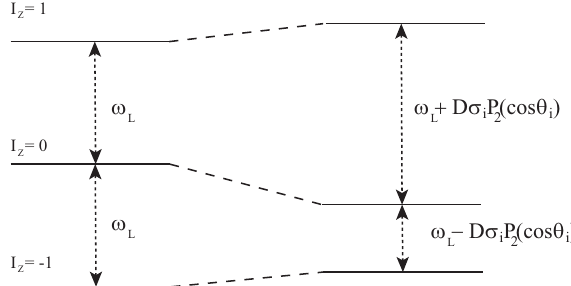
Figure 4. Nuclear Zeeman energy levels for one ortho-H 2 molecule calculated for total molecular nuclear spin I = 1 and angular momentum J = 1. Each molecule contributes a doublet with absorption frequency ω = ω L ± D σ i P 2 ( cos θ i )